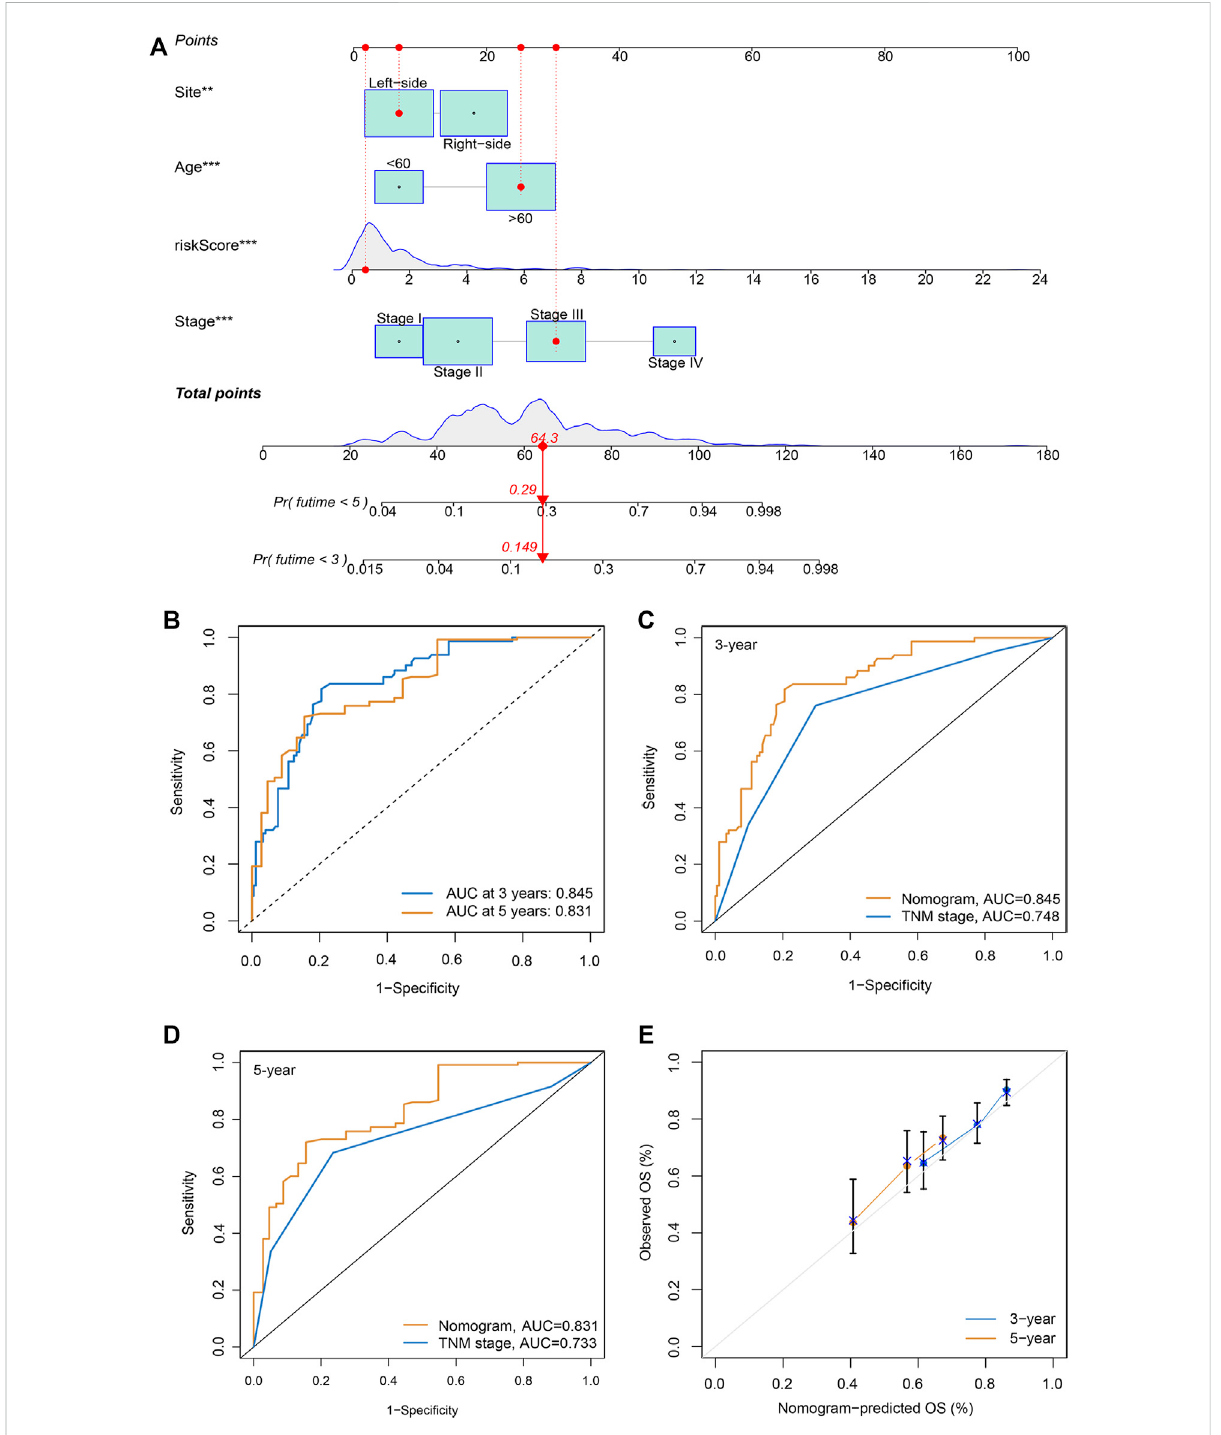
FIGURE 3 Generation and validation of a nomogram scoring system. (A) A nomogram for both clinicopathological traits and risk score to predict 3-year and 5-year OS. (B) The 3- and 5-year AUC values to evaluate the performance of the nomogram. (C,D) Comparison of the AUCs of the nomogram and TNM staging system at 3 and 5 years. (E) Calibration curve of the nomogram for predicting 3- and 5-year